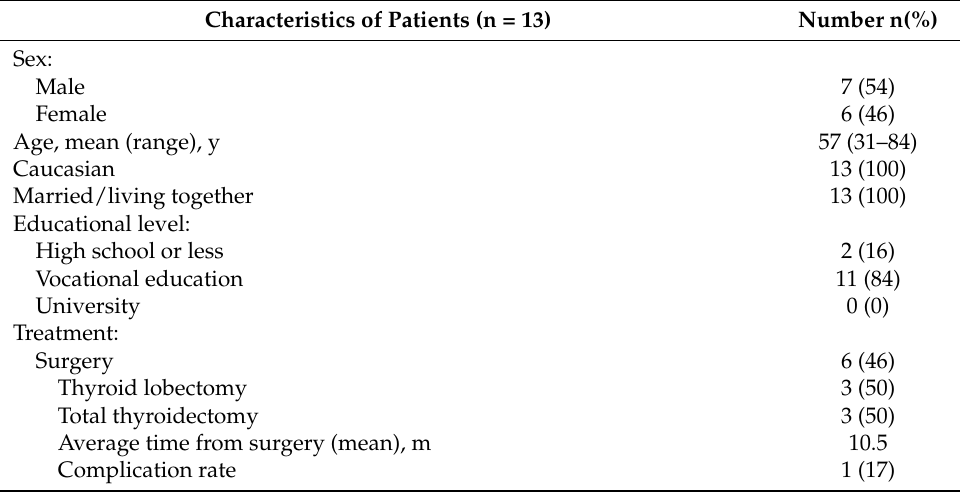
Table 1. Characteristics of participating patients and